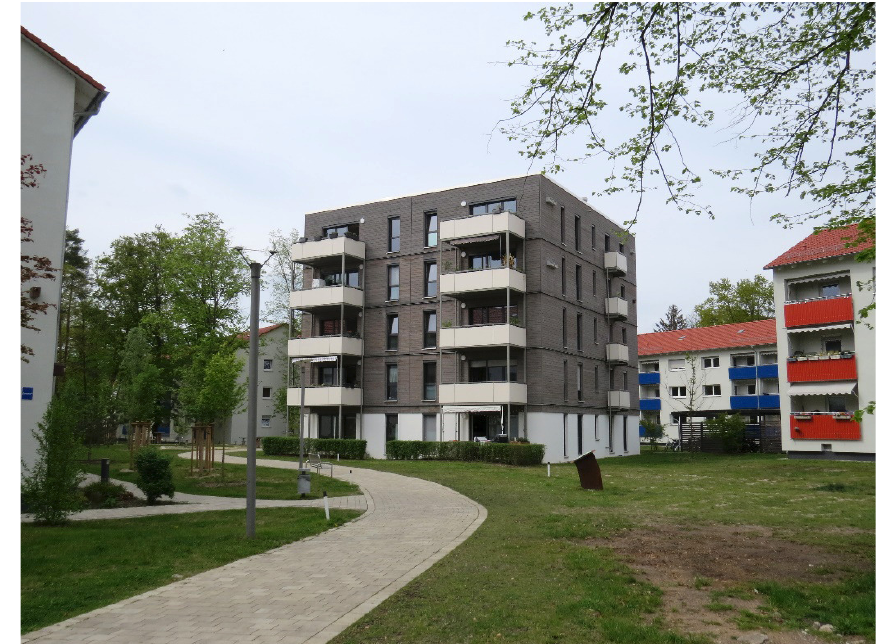
Figure 4. Newly arranged area of the Rathenausiedlung, now renamed